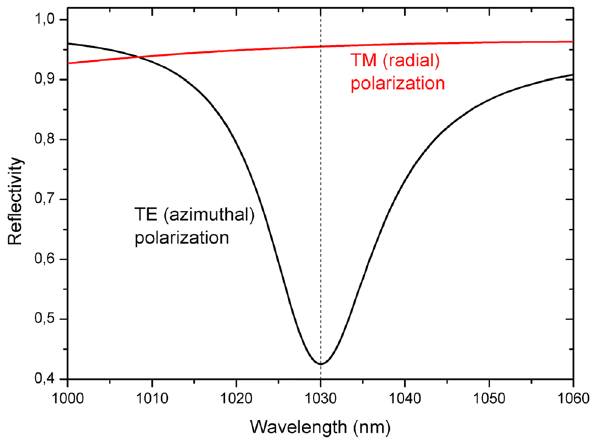
Figure 3: Calculated TE and TM reflectivity for a multiple corrugated